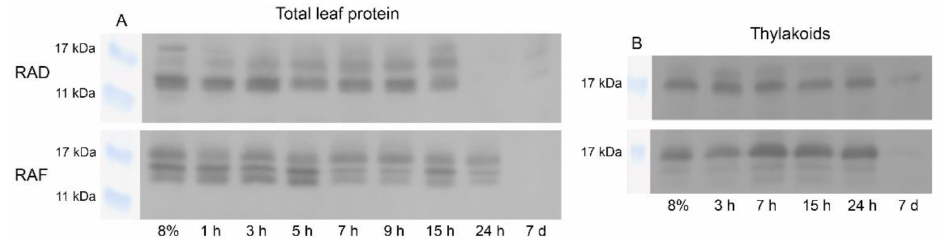
Figure 10. Changes in the relative amount of ELIPs, detected by Western blot analysis with anti-ELIP antibody in the total leaf proteins ( A ) and in thylakoids ( B ) isolated from H. rhodopensis plants during rehydration after drought- (RAD) and freezing-induced (RAF)